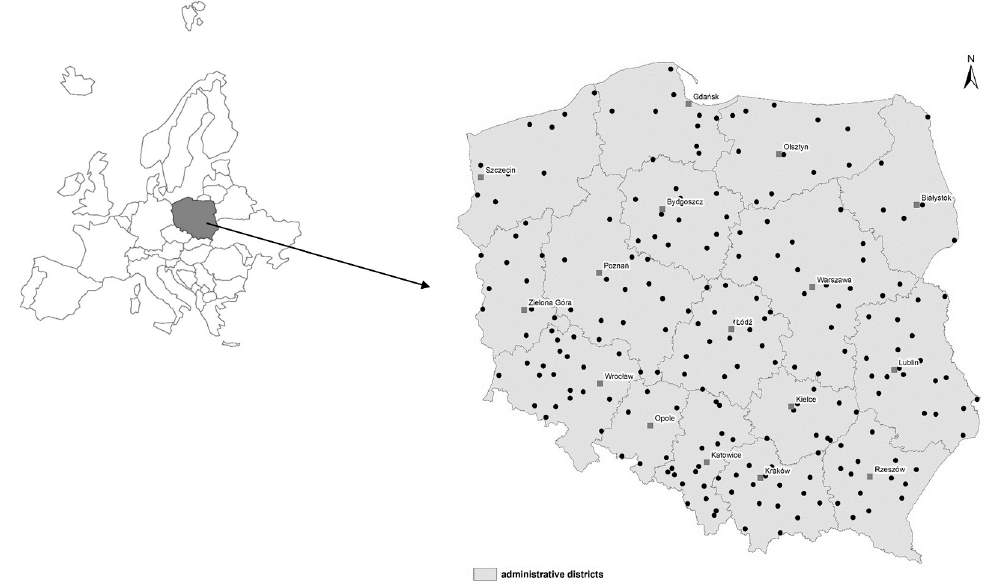
Figure 2. Sampling point map of research area (Poland).